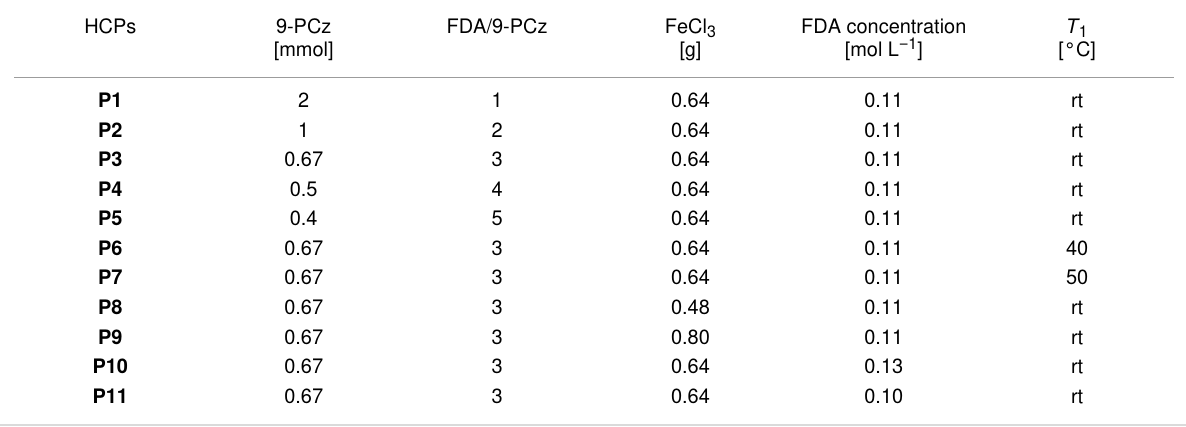
Table 1: Reaction conditions for the preparation of